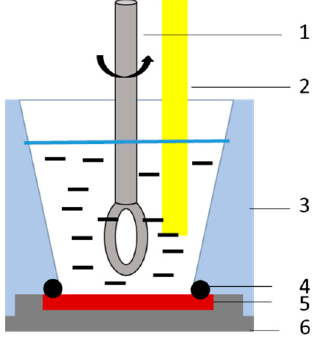
Figure 1. Electro-precipitation cell: ( 1 ) plastic coffee stirrer connected to a mechanic rotating system; ( 2 ) platinum anode; ( 3 ) glass cell; ( 4 ) O ring plastic seal; ( 5 ) stainless steel or BBD planchet cathode; ( 6 ) stainless steel support with an electrical contact.